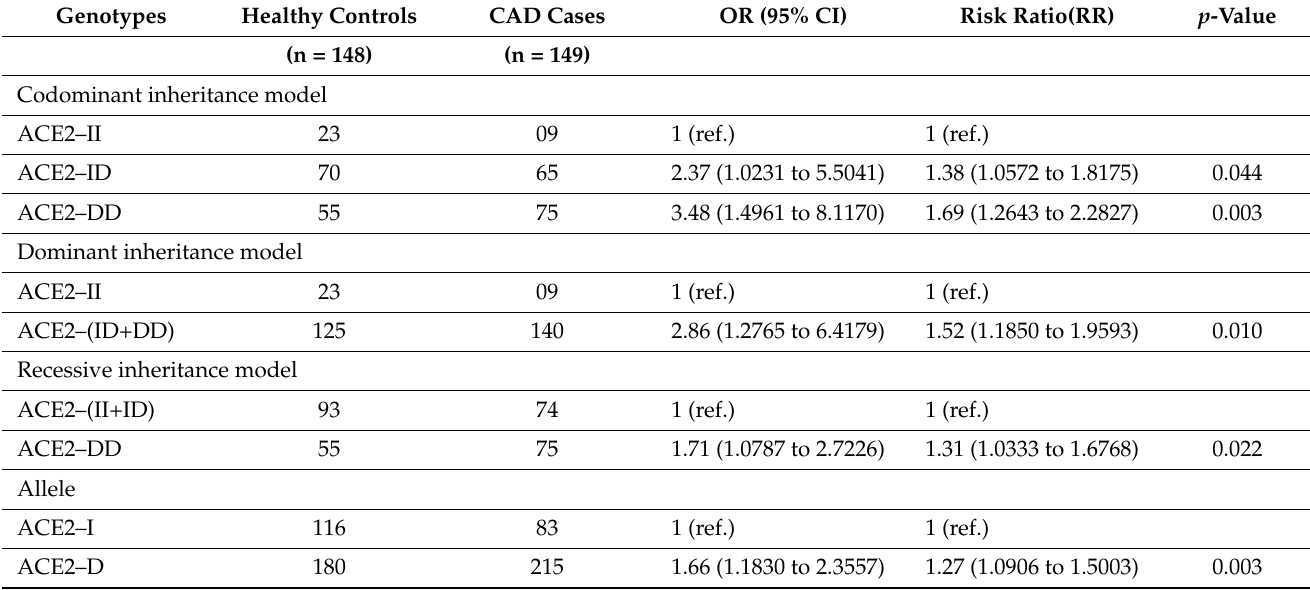
Table 4. Multivariate analysis of ACE2 I/D polymorphism in the coronary artery disease patients and healthy